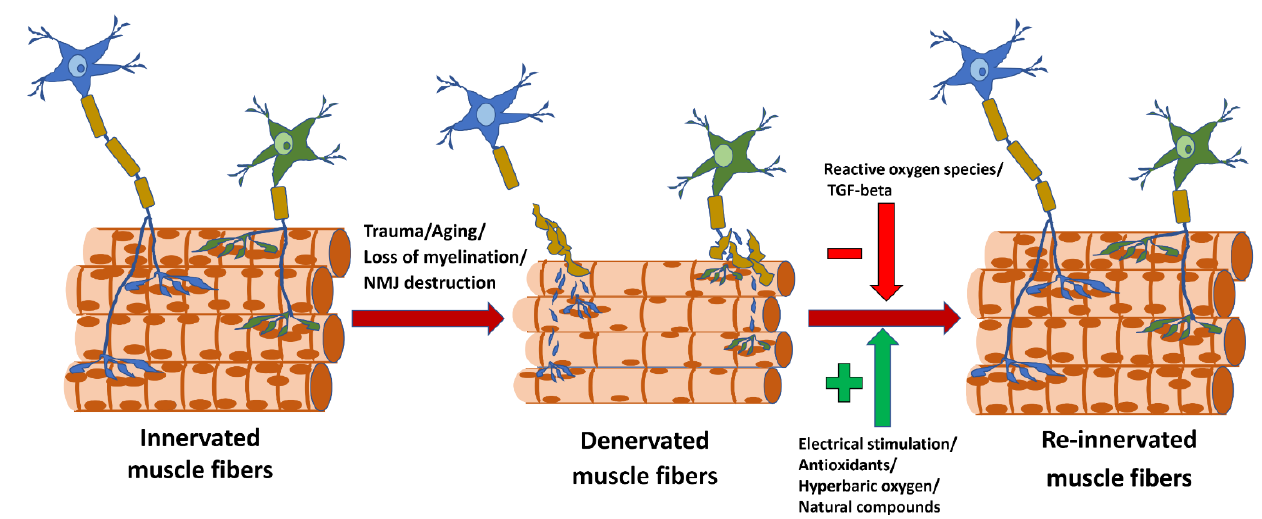
Figure 1. Schematic picture of muscle innervation/denervation/re-innervation processes. Denervation not only leads to muscle atrophy but also affects muscle metabolic func- tions. The study from Dr. Witczak’s laboratory published in the current Special Issue describes the effect of denervation on insulin resistance [14]. Although both slow (soleus) and fast (extensor digitorum longus or EDL) muscle atrophied equally to about 40% after 28 days of denervation, changes in insulin sensitivity were completely different. GLUT 4 transporter was increased in fast EDL muscle and decreased in slow soleus muscle. This correlated with the development of insulin resistance in soleus but increased insulin sensi- tivity in the EDL muscle. Considering that aging-associated denervation of skeletal muscle predominantly affects fast muscle fibers with relative sparing of slow muscle fibers [1], it is interesting what effect this could have on glucose metabolism in the